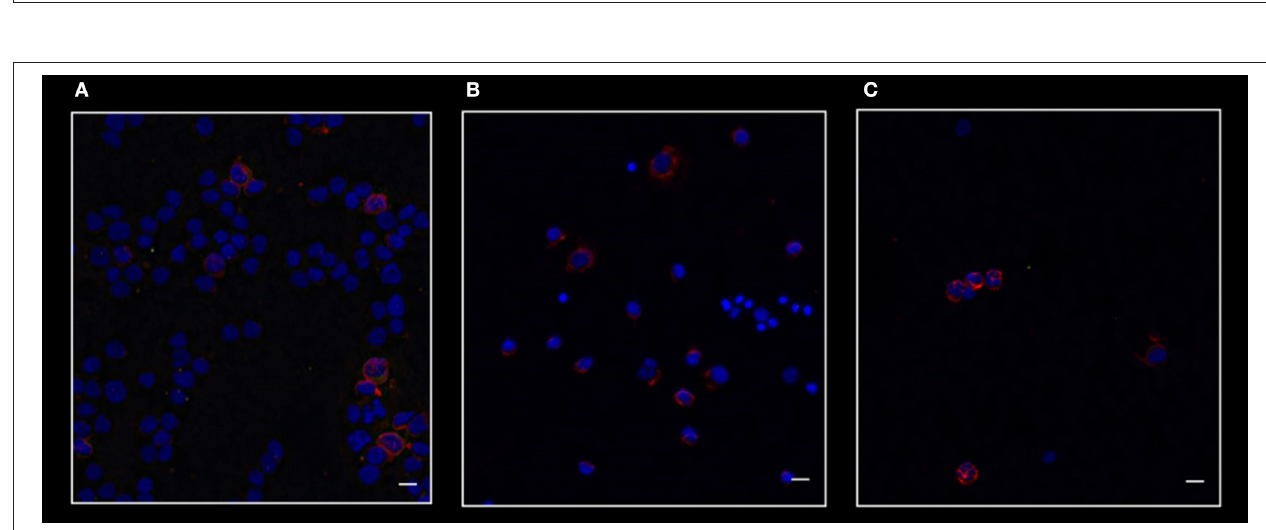
FIGURE 5 | Confocal laser scanning microscopy: representative images of bone marrow smears from patients with acute myeloid leukemia (A), essential thrombocytemia (B), and follicular lymphoma (C). Scale bars 10 µ m. Reactions for BMI1 (red), BCR-ABL1 (green), and CD26 (gray). It is clear that in these malignancies only BMI1 is expressed. As expected, these diseases are all CD26- and BCR-ABL1-negative.